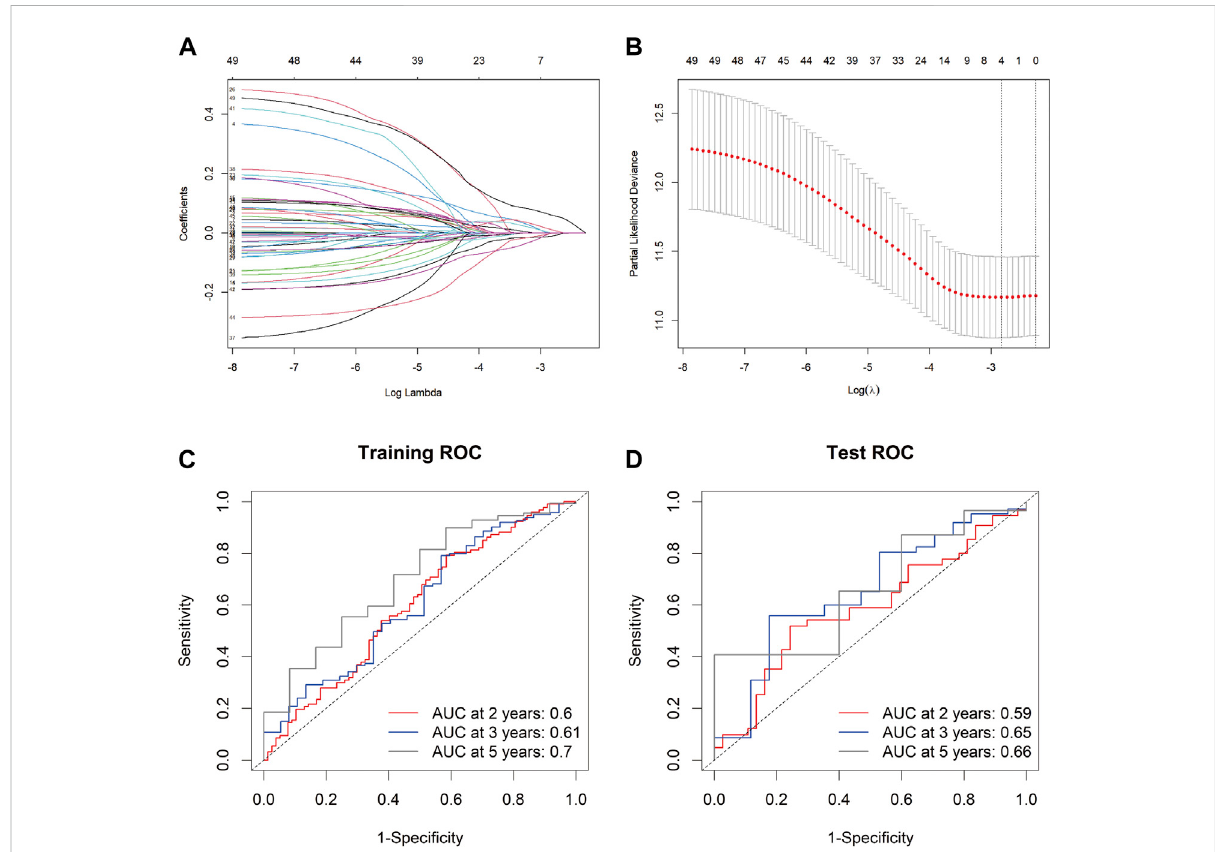
FIGURE 4 The PrognosisScore model and its prognostic signi fi cance. (A) Least absolute shrinkage and selection operator (LASSO) coef fi cient pro fi les of the four key molecules. (B) Tuning parameter selection by tenfold cross-validation in the LASSO model. The partial likelihood deviance was plotted against log(Lambda/ λ ),and λ wasthetuningparameter.Thepartiallikelihooddeviancevalues areshown,and errorbarsrepresented s.e.The dotted verticallinesshowingtheoptimalvaluesthroughminimumcriteriaand1-s.e.Criteria. (C,D) ThePrognosisScoremodelwasmeasuredbytime- dependent receiver operating characteristic (ROC) curves in the training set and the test